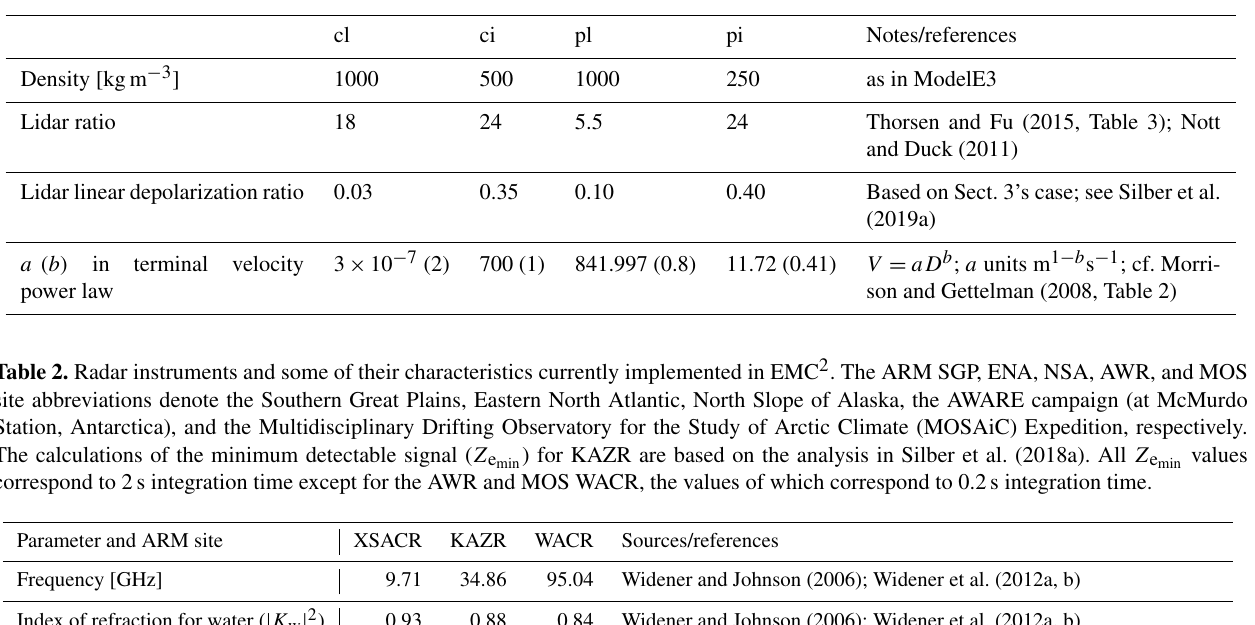
Table 1. Hydrometeor class parameter values implemented in EMC 2 .